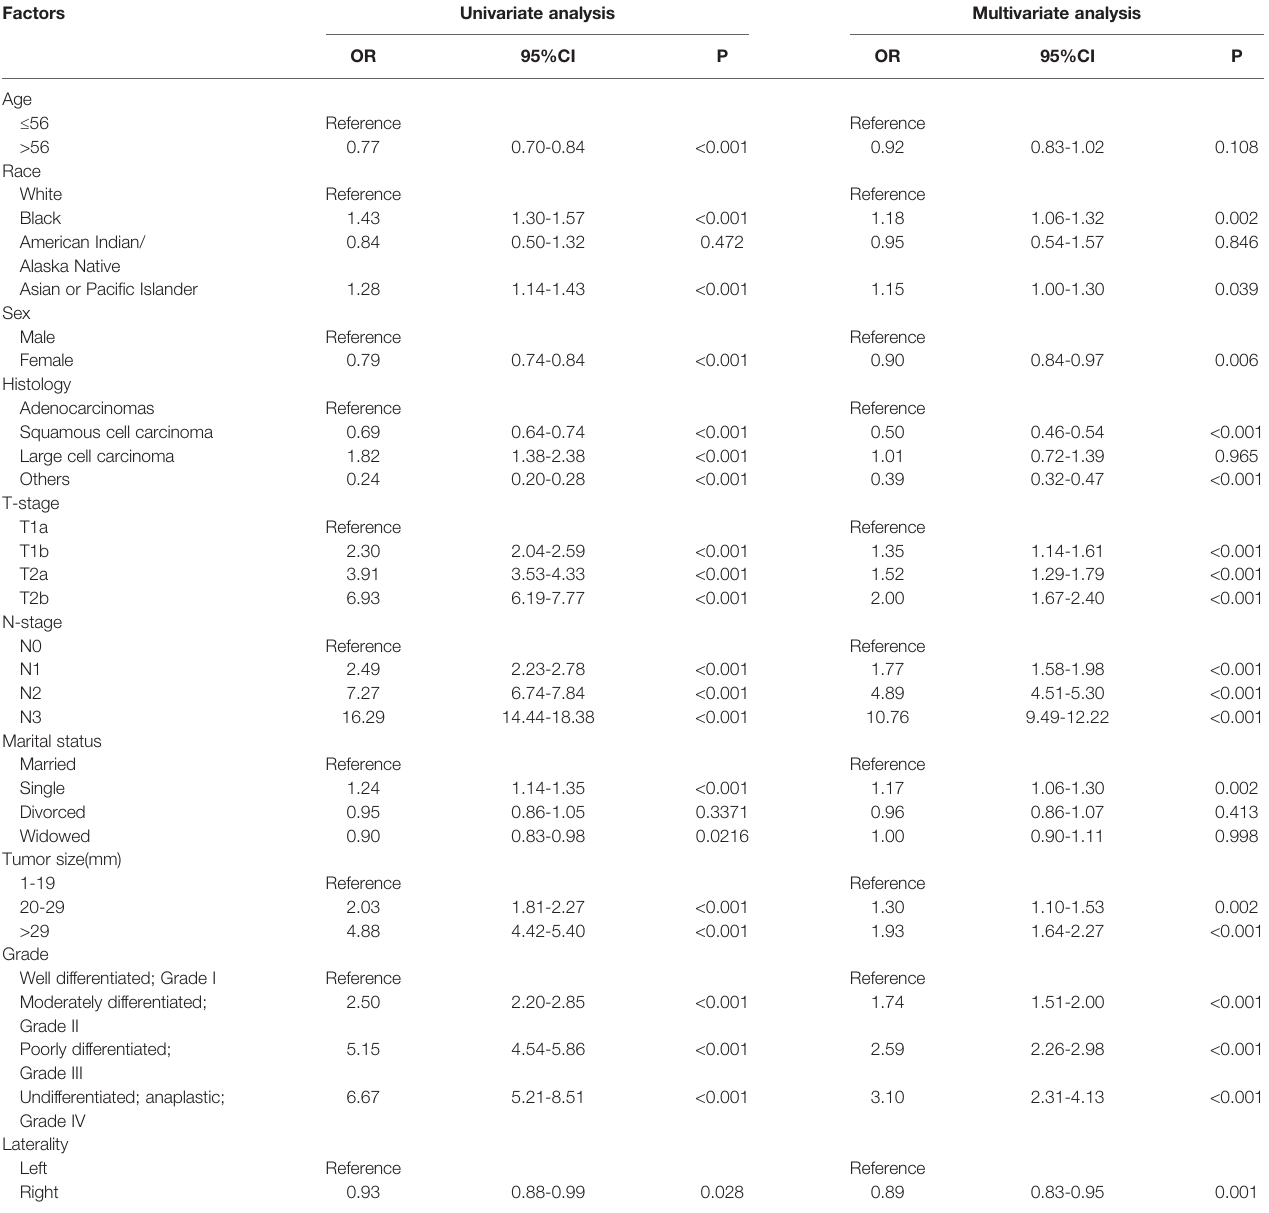
TABLE 4 | Logistic regression analysis of the risk factors for distant metastasis in cohort M. Factors Univariate analysis Multivariate